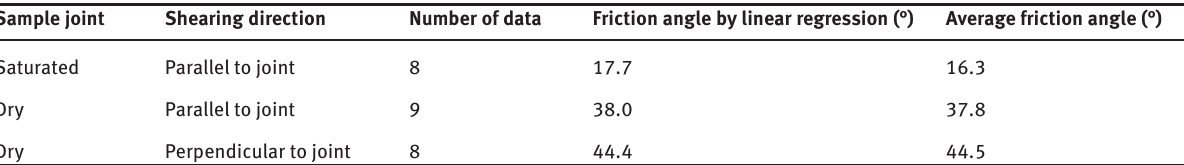
Table 5: Values of residual friction angle of Campolattaro marls for different conditions of humidity and shearing direction (data from ISMES 1982).